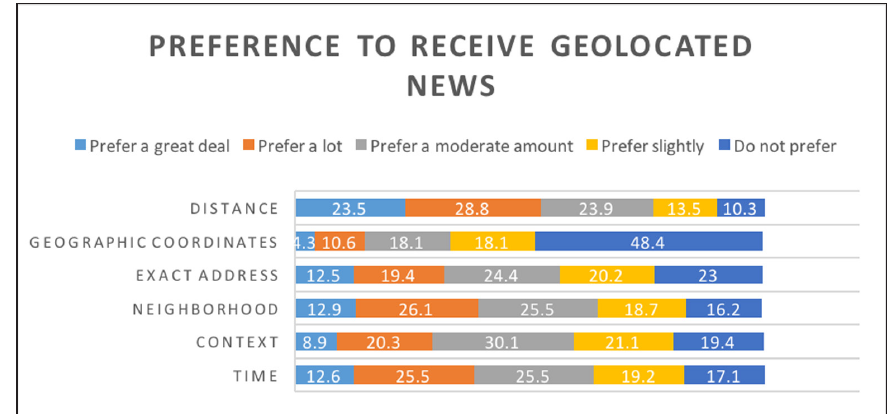
Figure 3: Preference to Receive Geolocated